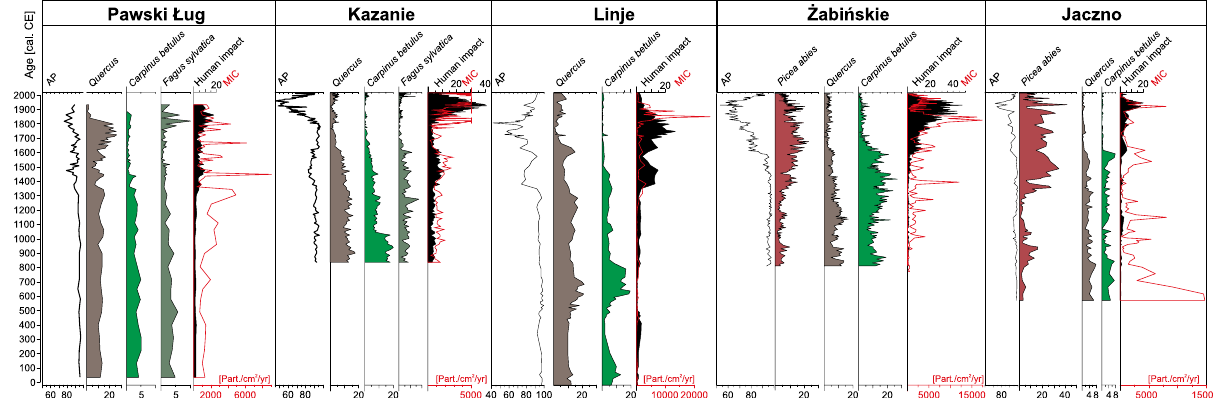
Figure 4. Simplified percentage pollen diagrams from five sites (with secure dating and high-resolution pollen data) located along north-western to north-eastern direction. Selected pollen taxa, composite pollen curves (AP and anthropogenic pollen indicators) and micro-charcoal influx (MIC) are